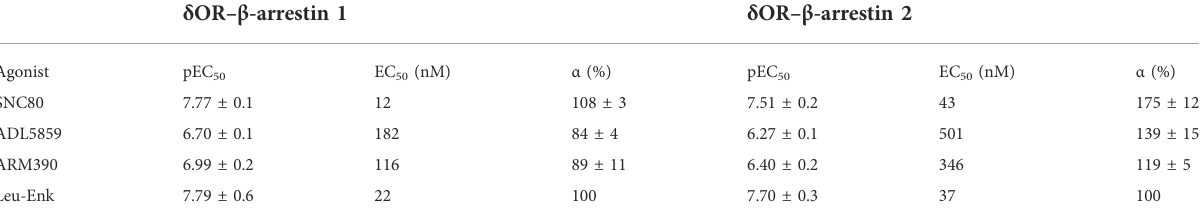
TABLE 1 Average potency (pEC 50 ) and Emax ( α ) values with standard error of the mean (SEM) for δ OR agonists in recruiting β -arrestin 1 and β -arrestin 2. All agonists were tested n ≥ 3. δ OR – β -arrestin 1 δ OR – β -arrestin